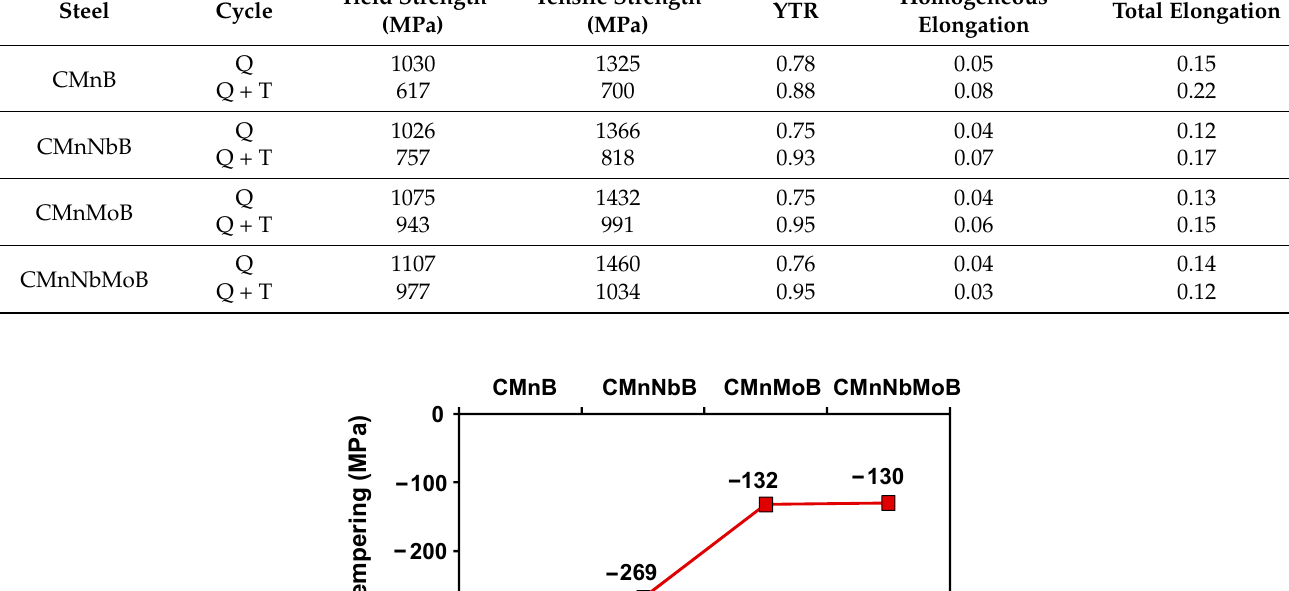
Figure 11. Reduction of yield strength and tensile strength after tempering treatment. Table 3. Tensile properties measured before and after tempering treatment for all the chemistries (YTR: yield-to-tensile ratio).